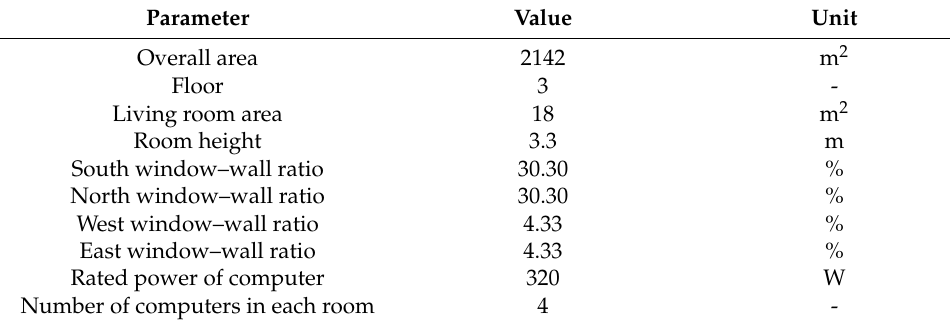
Table 2. Structural parameter of dormitory model.